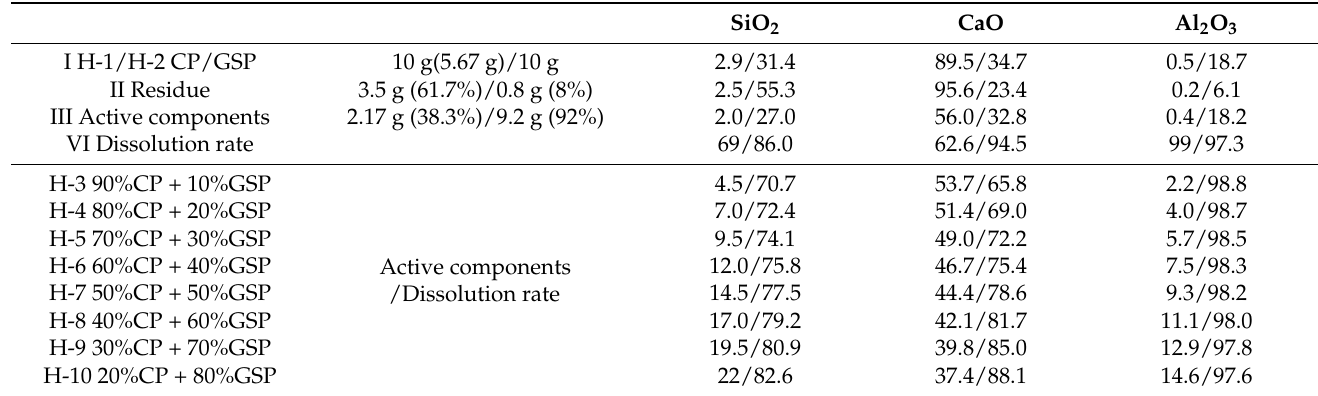
Table 3. Reactivity of CP/GSP determined by chemical dissolution and XRF (wt %). SiO 2 CaO Al 2 O